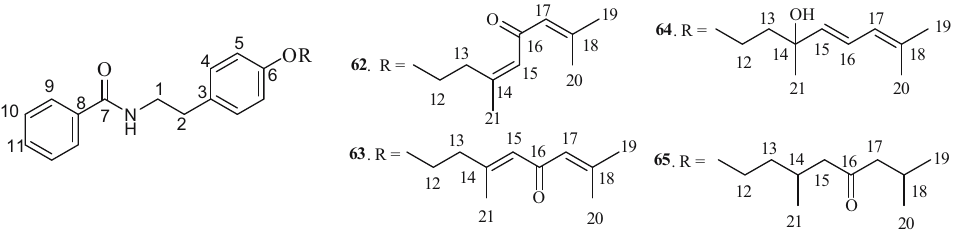
Figure 7: Structures of N - benzoyltyramide derivatives from Casimiroa